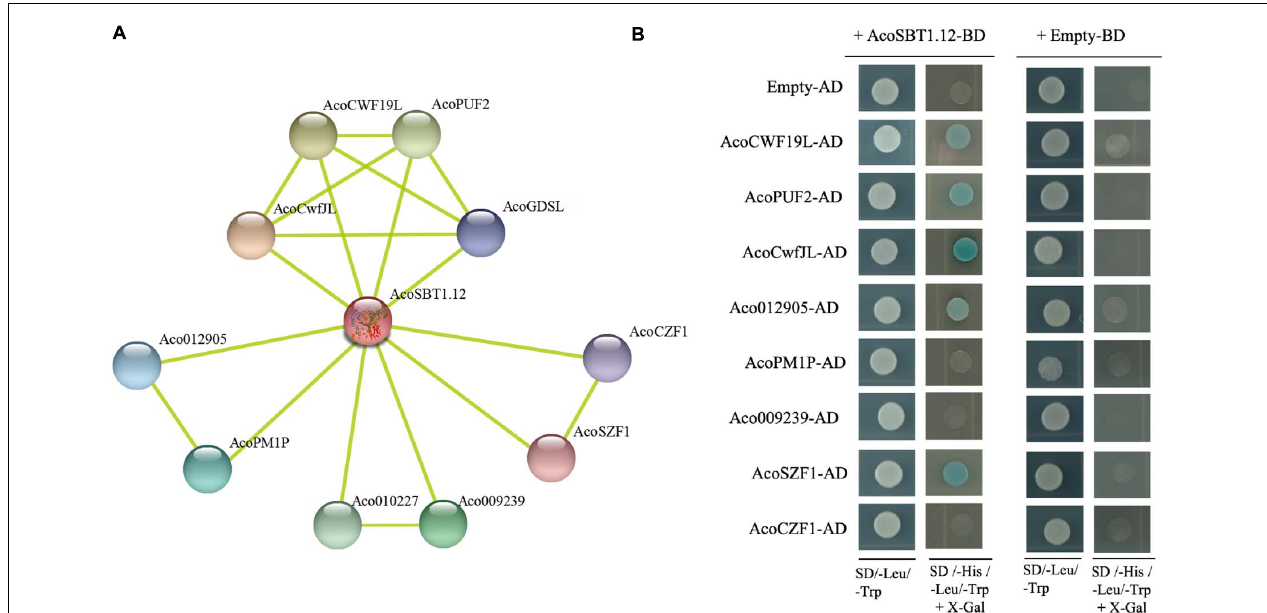
FIGURE 9 | AcoSBT1.12 influences flowering time. (A) The network prediction of AcoSBT1.12 and its interaction protein based on STRING database. (B) Protein interactions between AcoSBT1.12 and predicted protein by yeast two-hybrid